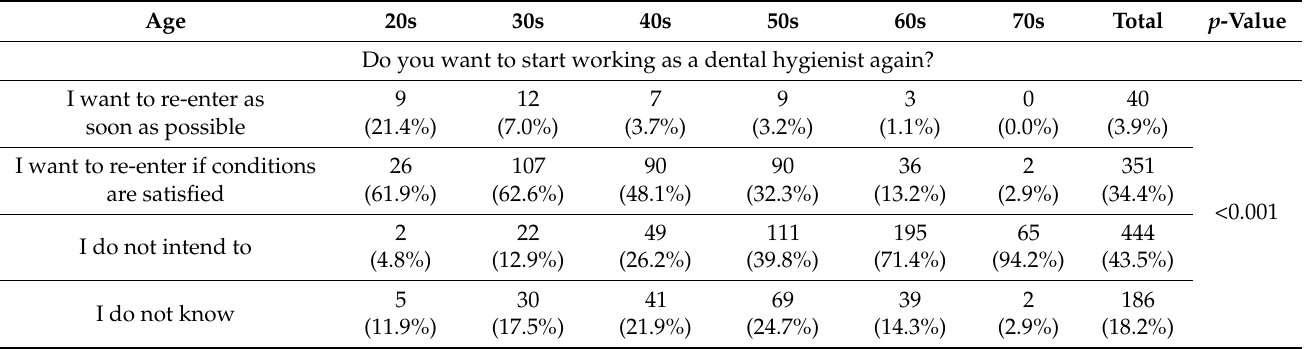
Table 1. Cross-tabulation of the items investigated in this study against age